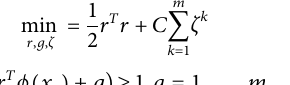
FIGURE 7 Blood glucose changes using the